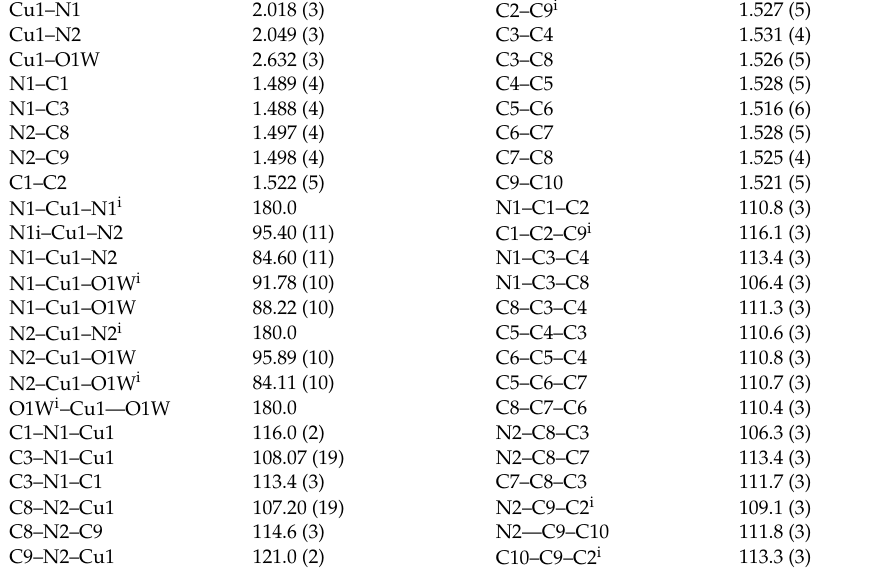
Table 2. Selected bond distances (Å) and angles ( ◦ ) of complex (I).